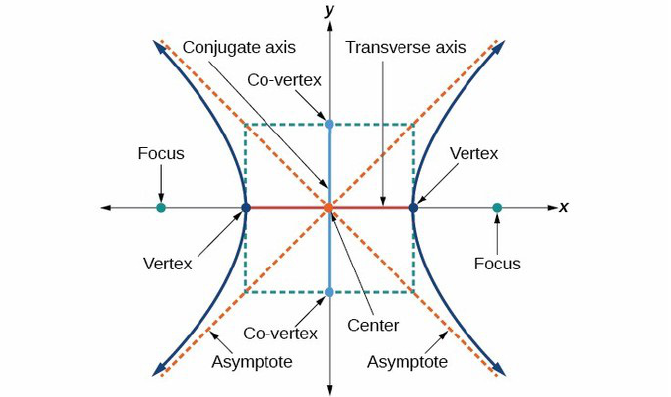
Fig. 12 x-axis distance difference of a single feature